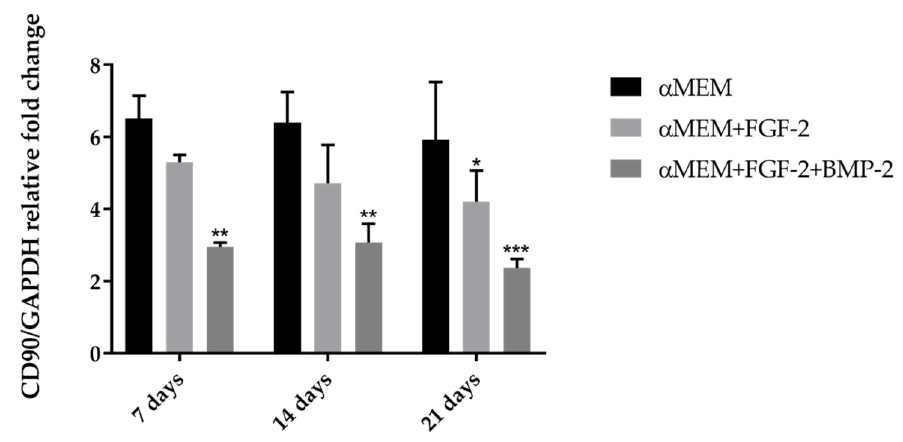
Figure 4. RT-PCR (reverse transcription polymerase chain reaction) analysis for CD90 gene expression of BM-MSCs cultured in the α MEM medium supplemented with or without BMP-2 and / or FGF-2 for 7, 14, and 21 days. The highest level of CD90 was observed in cells cultured in the control medium α MEM for all time points. In contrast, BM-MSCs treated with FGF-2 and BMP-2 were characterized with the lowest level of CD90 . The experiment was assessed three times in duplicate. * p < 0.05, ** p < 0.005, *** p < 0.0001.